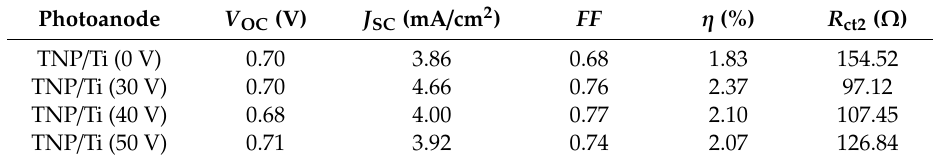
Table 1. The photovoltaic parameters, charge-transfer resistance and collection e ffi ciency for the FDSSC with TNP / Ti wire and TNP / TNT-printed Ti wire